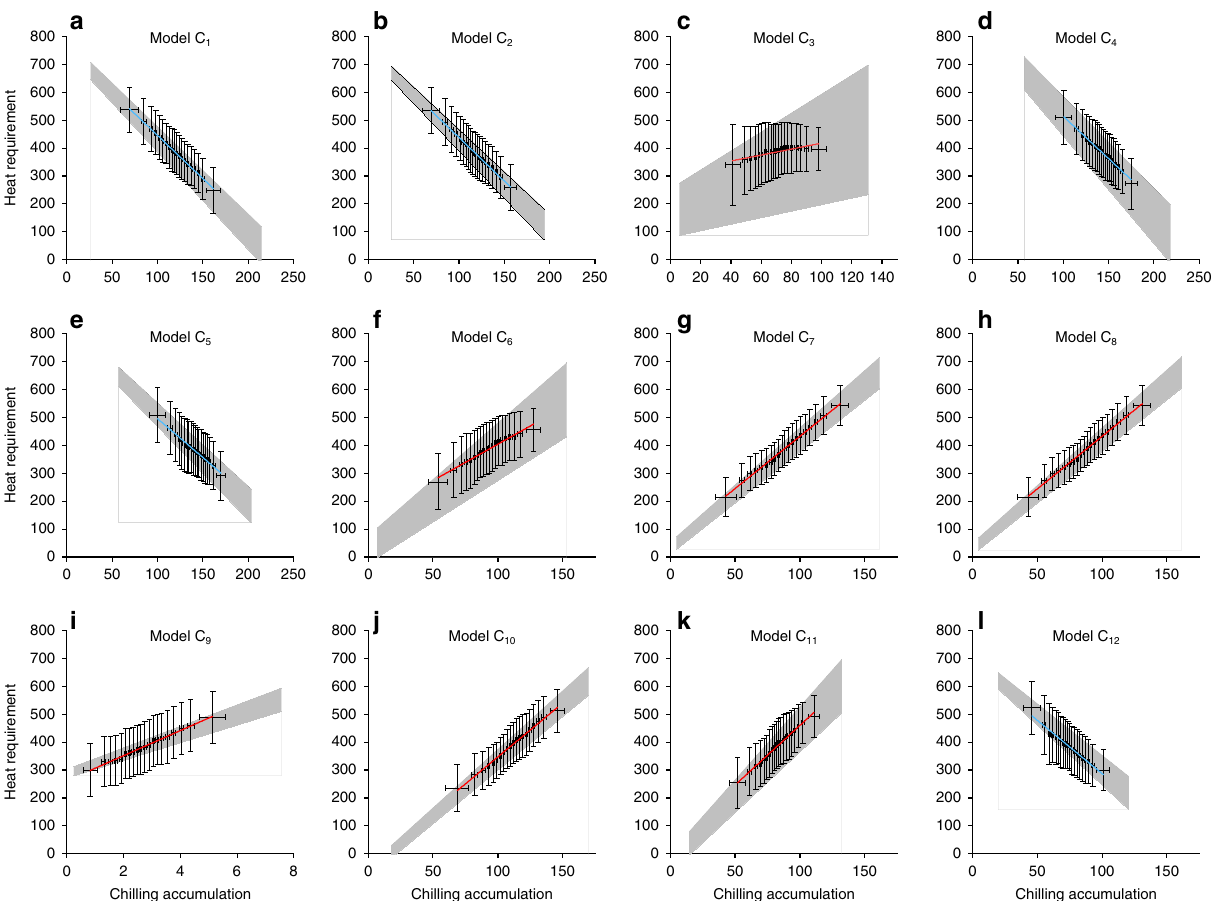
Fig. 3 Relationship between CA and HR for leaf-out of Betula pendula . Chilling accumulation (CA) from the previous 1 November to the leaf-out date was calculated using the 12 chilling models. Heat requirement (HR) was an integration of daily mean temperatures >0 °C from 1 January to the leaf-out date. a – l Models C 1 – C 12 . Data are divided into 20 groups with the same number of records. Error bars, mean values ± SD of HR or CA within each group ( n = 6301 records). The linear regression lines (blue for negative correlations and red for positive correlations) are shown for each model. The shaded area shows the uncertainties, which were estimated by using the 95% con fi dence interval for slope and interception of regression